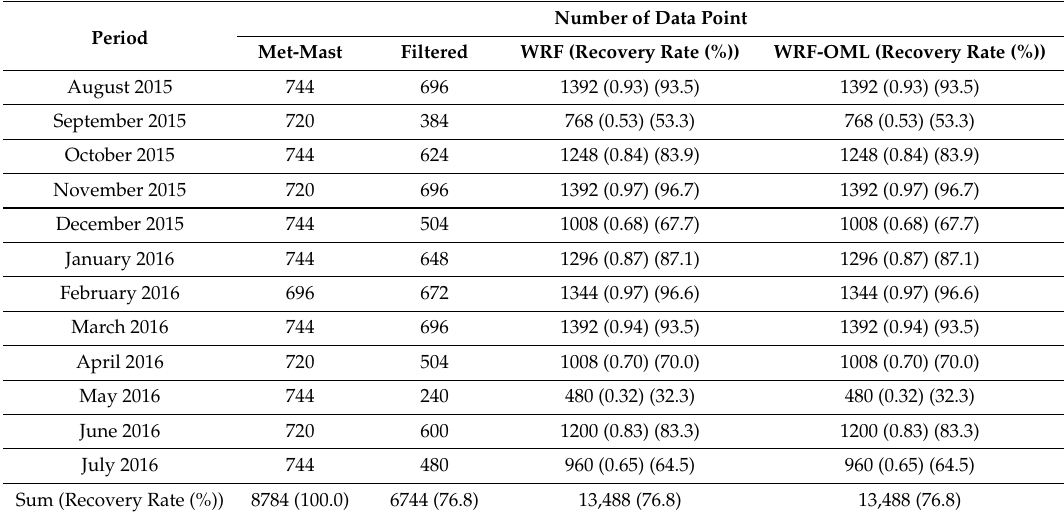
Table 3. Number of observation data and model data